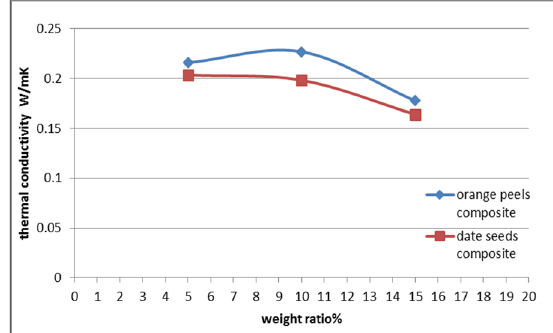
Fig. 12. Thermal Conductivity coefficient results for natural composite material for different weight ratio .